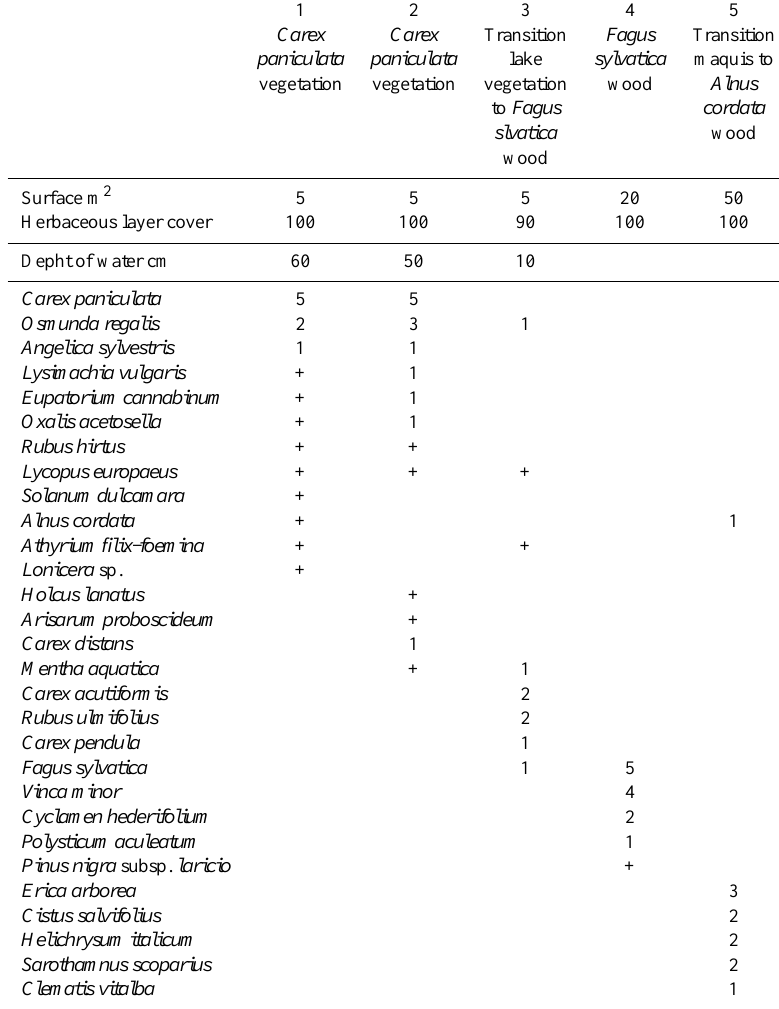
Table 2. Relev´e of vegetation from the peat/lake numbered 1 to 3, and from the surrounding forest of Fagus (4) and maquis with Alnus cordata (5). Codification of surface sample cover is as follows: 5=100–80%; 4=80–60%; 3=60–40%; 2=40–20%; 1=20–1%; += < 1%.